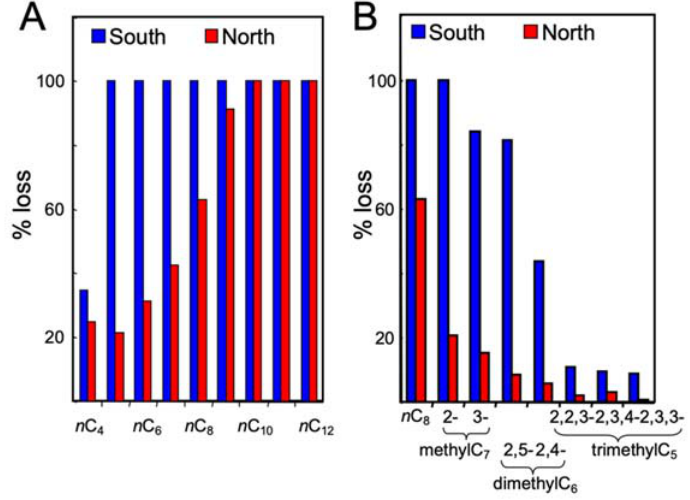
Figure 4. Biodegradation of the n -alkanes ( A ) and iso -octanes ( B ) in gasoline in water from the South and North Arms of the Great Salt Lake after 90 days of incubation. Panel ( B ) shows the detected isomers of octane.